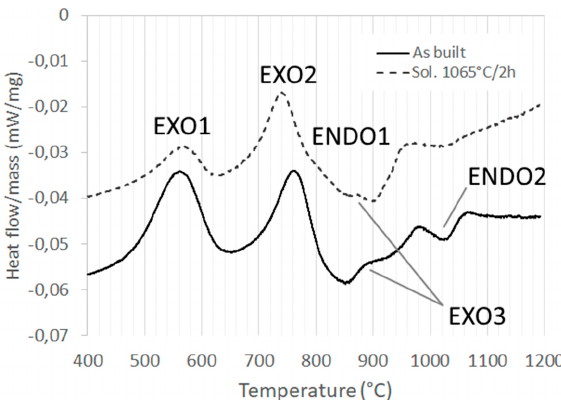
Figure 18. Differential scanning calorimetry (DSC) curves recorded on selective laser melting (SLM) Inconel 718 in the as-built state (full line) and solution heat treated at 1065 ◦ C for 2 h (dotted line). The labels indicate the peaks related to exothermal (EXO) and endothermal (ENDO) phenomena.